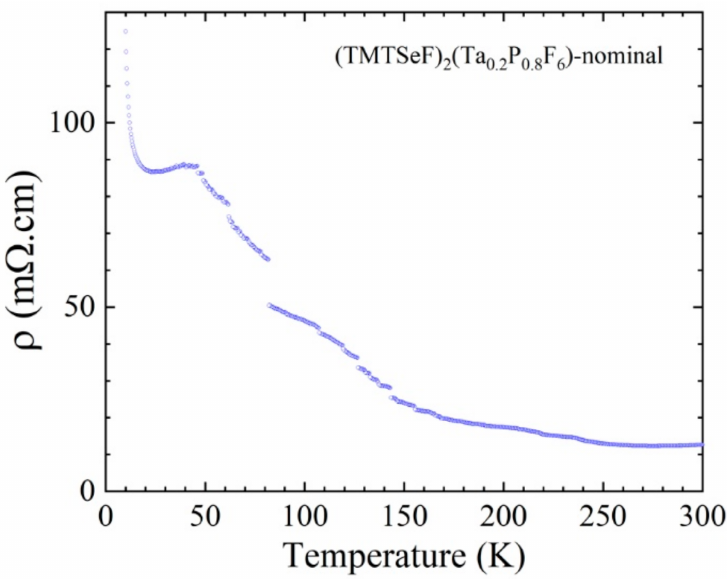
Figure 11. Temperature dependence of the electrical resistivity of a single crystal of (TMTSF) 2 (Ta 0.2 P 0.8 F 6 )-nominal measured in two